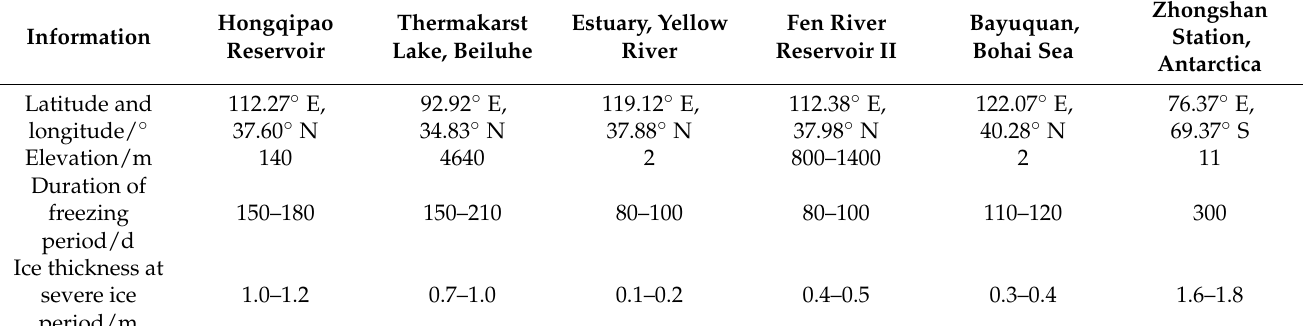
Table 1. Basic information about the site for the survey and research on ice thermal properties.